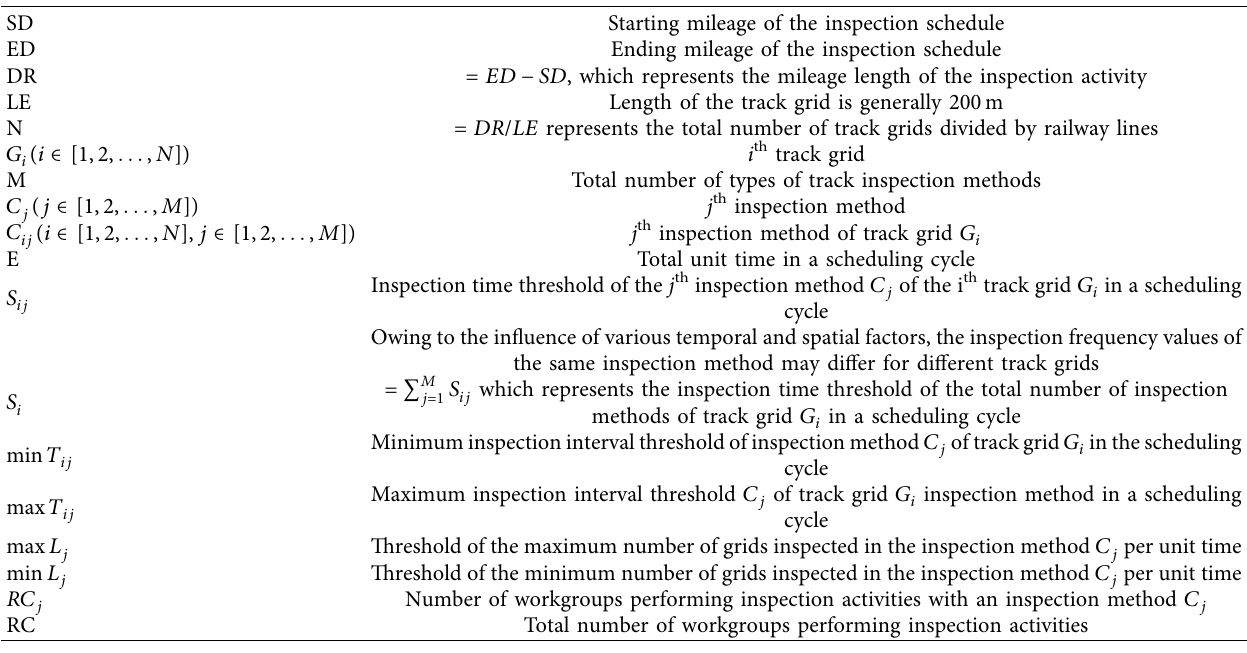
Figure 3: Comparison of the condition before and after subdivision of railway track inspection activities based on the time-location grid. (a) Diagram of railway inspection schedule. (b) Diagram of time-location grid-based railway inspection schedule. Table 1: Variable